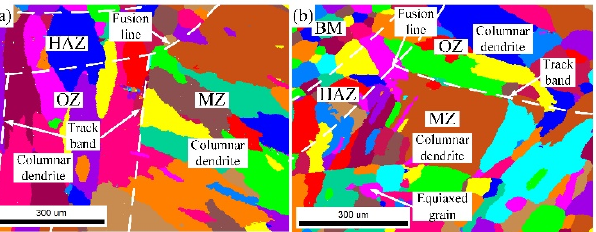
Figure 8. The grain morphology near the in-air and underwater fusion line: ( a ) the in-air grain morphology; ( b ) the underwater grain morphology.